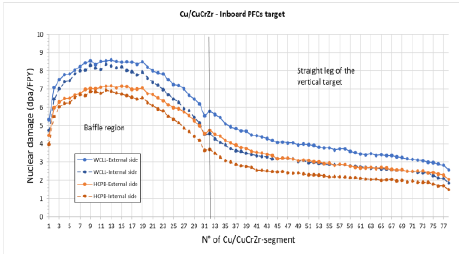
Figure 40. Inner poloidal profiles of the nuclear damage (dpa/FPY) on Cu/CuCrZr components, comparing the values on the external and the innermost target sides, both for WCLL and HCPB blanket case.